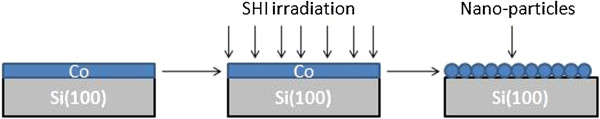
Schematic diagram of nanoparticle synthesis by SHI irradiation.